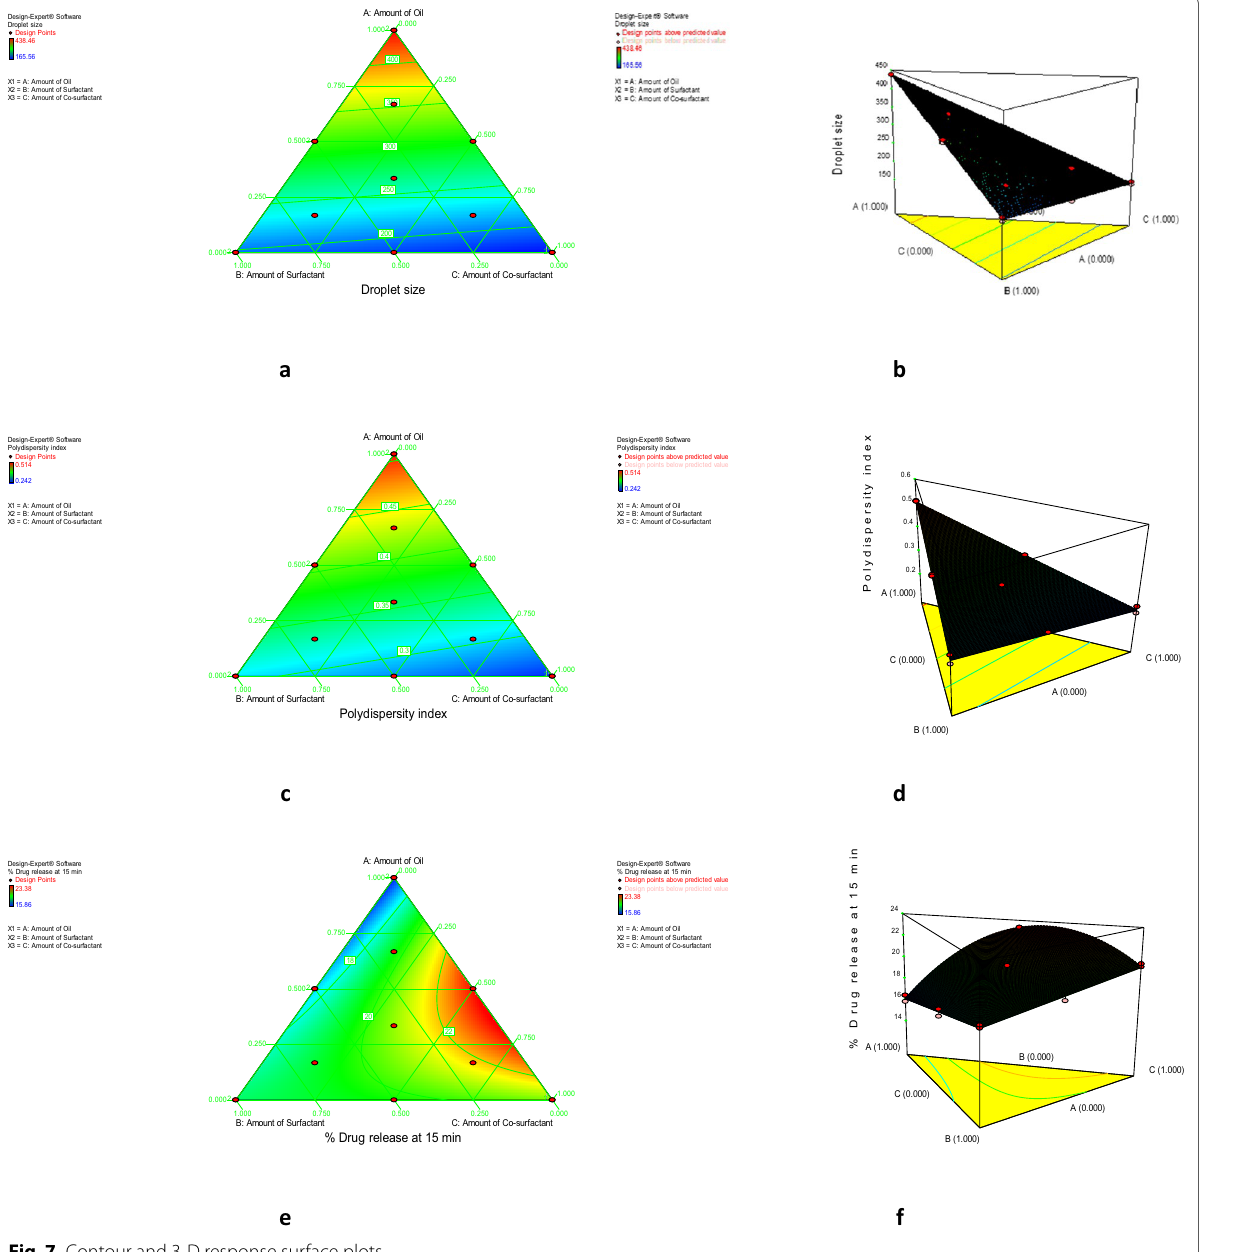
Fig. 7 Contour and 3-D response surface